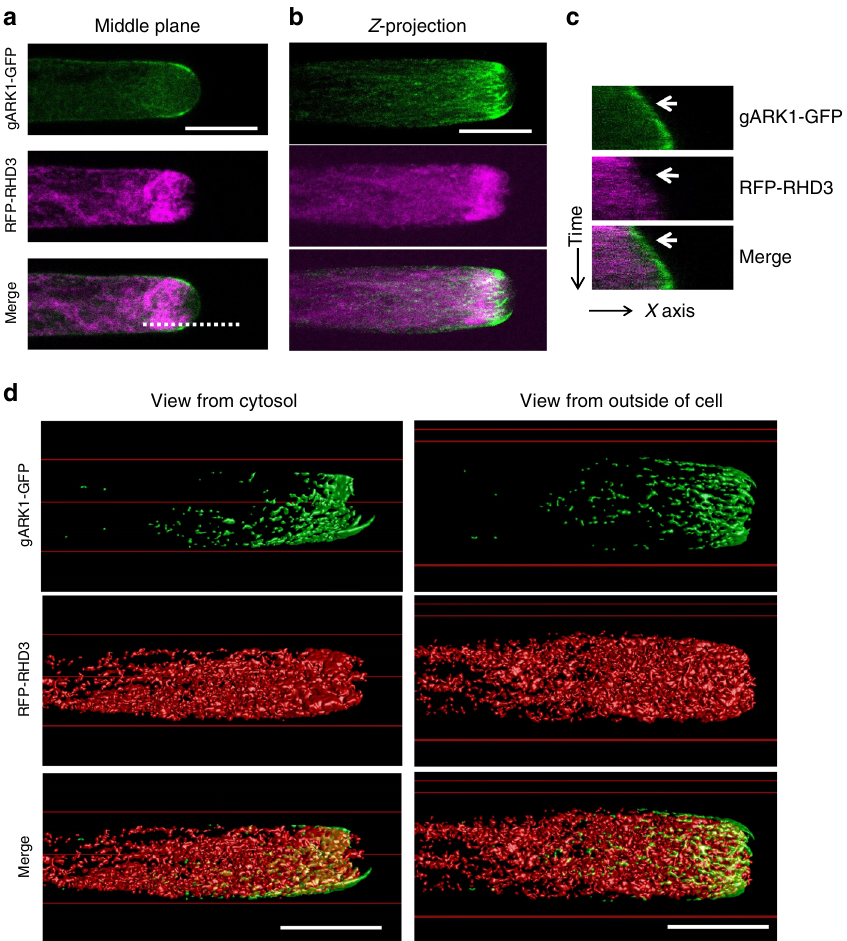
Fig. 6 Cortical ARK1 overlaps and co-moves with RHD3 in the cortex of the subapical region of growing root-hair cells. a , b Distribution of cortical gARK1 – GFP and subapex-focused RFP-RHD3 in the midplane ( a ) and Z-projection ( b ) in the subapical region of a growing root-hair cell. The experiment was independently repeated three times. c Kymograph of gARK1 – GFP and RFP-RHD3 in the midplane. The dash line in ( a ) show the region used for the analysis. d Spatial relation of gARK1-RFP (top and merged panels) and RFP-RHD3 (middle and merged panels) in a 3D model. The left image is a view from the cytosol; the right is a view from the outside of the cell. Partial overlap was visible in the cortex of the subapical region. Scale bars indicate 10 µ